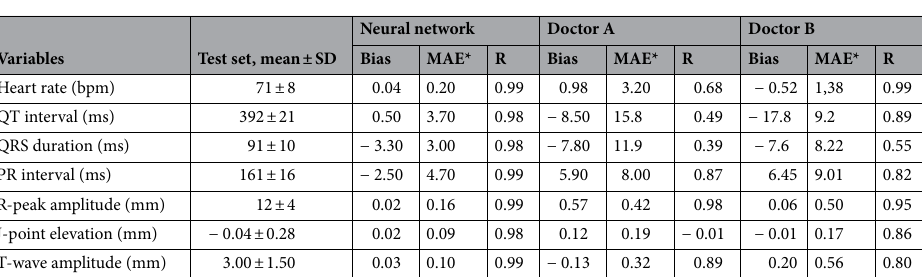
Table 4. Evaluation of twenty randomly selected ECGs by two experienced cardiologists. Bias is the average difference between the ground truth and the doctor/network. Mean absolute error (MAE*) is the bias- subtracted mean absolute error, to account for the fact that there is no universal correct measurement for an ECG, ensuring that any personal bias does not contribute to the error (e.g., some doctors measure QT consistently shorter or longer than others). R: Pearson’s correlation coefficient between the doctor’s two measurements/the neural networks five folds. SD Standard deviation.